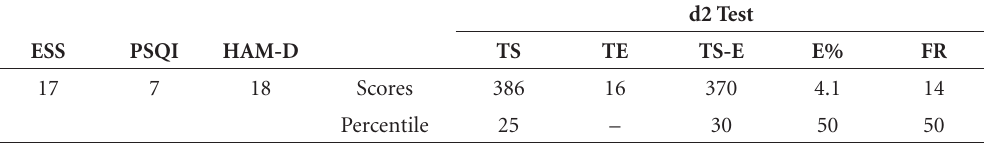
Table 1. Raw and scaled scores of subject 1 on the ESS, PSQI, HAM-D scales and d2Test.